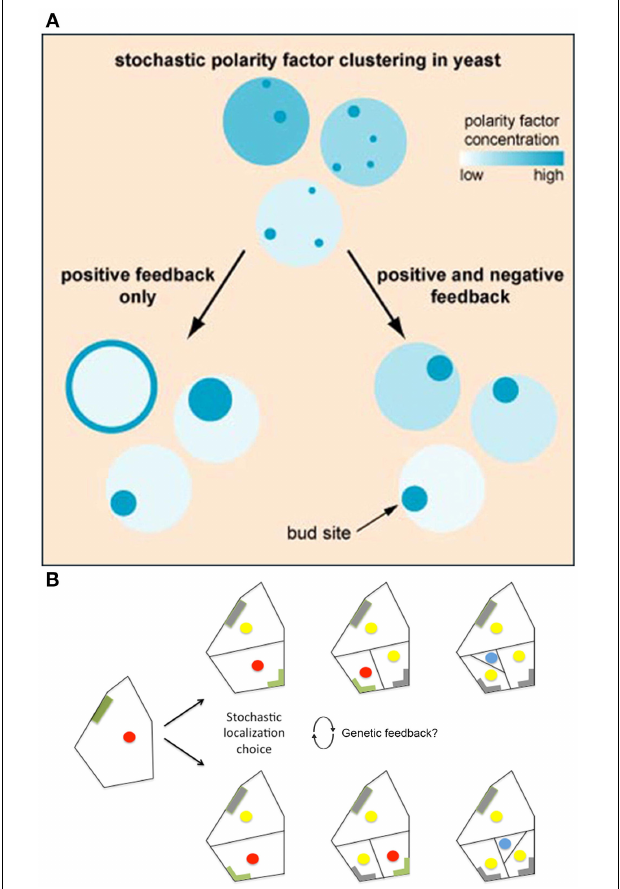
FIGURE 7 | Regulatory mechanisms stabilize cellular decisions initiated by stochasticity. (A) Yeast must select a single bug site and when landmark proteins are absent the site is selected stochastically. Computational modeling suggests that both positive and negative feedback loops are necessarytoamplifyandyetconstrainthisrandombudpolarizationtoensure that a single bud site is selected. In models with only positive feedback loops, stochastic fluctuations in polarity regulating complexes increase, causing polarity regulators to either disperse on the plasma membrane or form large patches (left). However, when negative feedback is added to the positive feedback model, a cell becomes less susceptible to noise, causing proper polarization (right). Reprinted from Howell et al. (2012) Copyright, with permission from Elsevier. (B) BASL undergoes polarity switching during asymmetric cell division in Arabidopsis . BASL (green) accumulates on the cell periphery farthest from the intended division plane. Once asymmetric division occurs, BASL disappears (gray) and re-accumulates on the farthest cell periphery of the newest daughter cell. When two equivalent locations in the periphery of the cell are available for BASL accumulation, BASL appears topickonerandomly.ThisraisesthequestionofwhetherBASLaccumulation is regulated by a similar stochastic mechanism to that observed in bud site selection in yeast. The blue dot represents the formation of a guard mother cell, the red dot represents nuclei with BASL accumulation, and the yellow dot represents nuclei without BASL accumulation. Adapted from Robinson et al. (2011). Reprinted with permission from